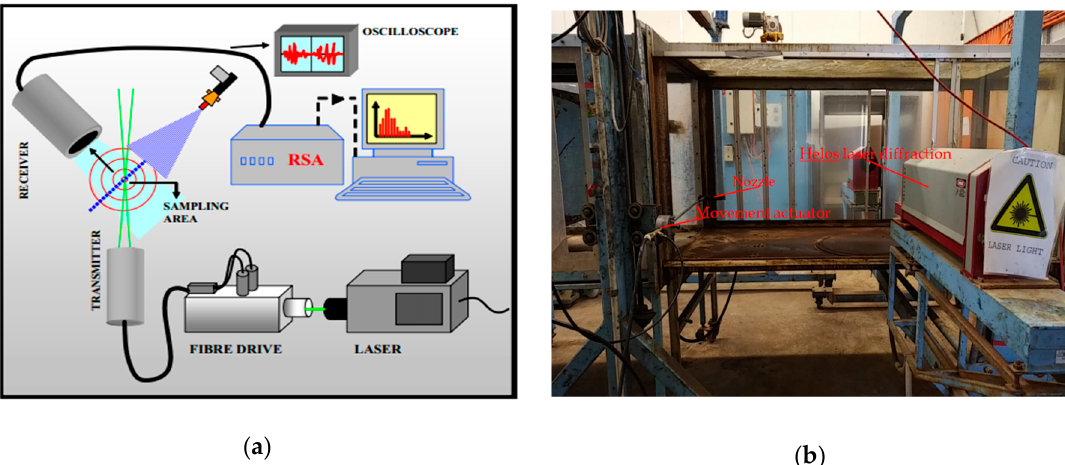
Figure 1. ( a ) The schematic of wind tunnel test system [22]. ( b ) The setup geometry and configuration of wind tunnel facilities. Note: The test nozzles were mounted on a vertical movement actuator, which was controlled by a programmable logic controller (PLC) to move the nozzle body at a constant speed. The Helos laser di ff raction system had a horizontal distance of 51 cm downwind of the test nozzles, which was su ffi cient for the breakup of the liquid